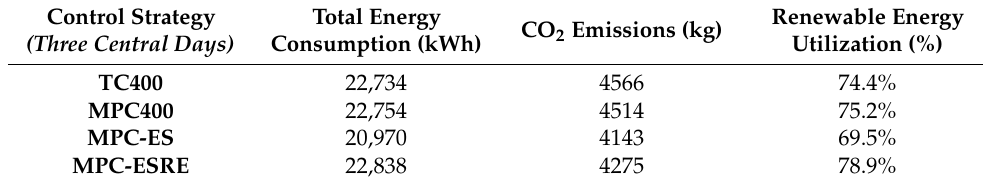
Table 5. KPI values for the multi-objective